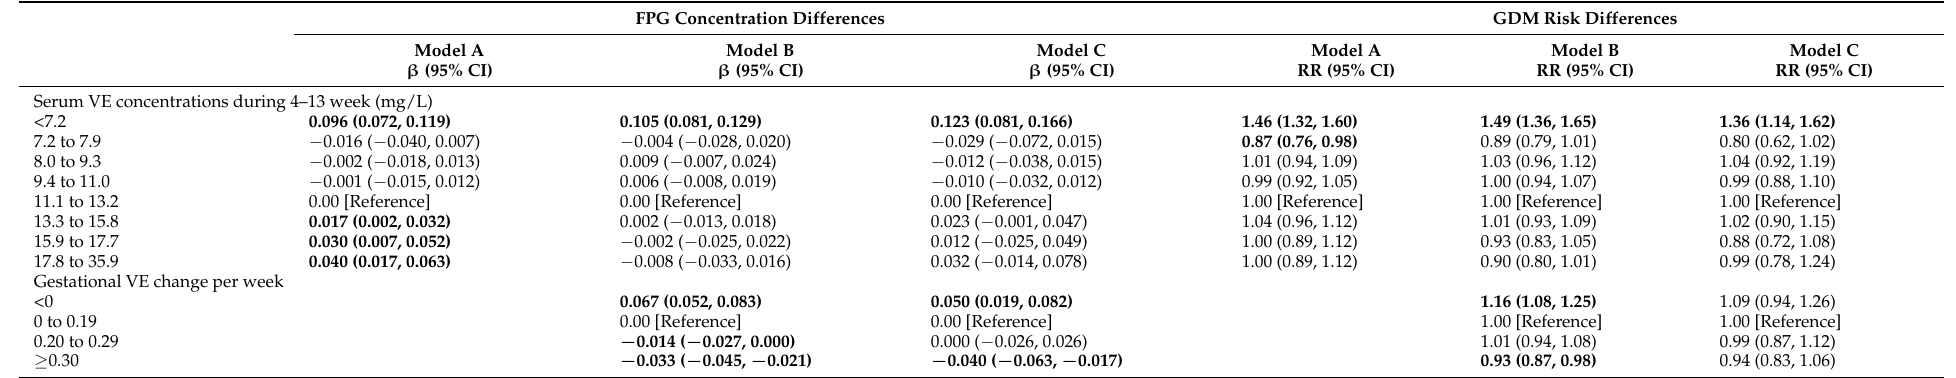
Table 2. Adjusted FPG concentration differences and relative risks for GDM according to the first-trimester vitamin E (VE) concentration categories and gestational VE change categories.